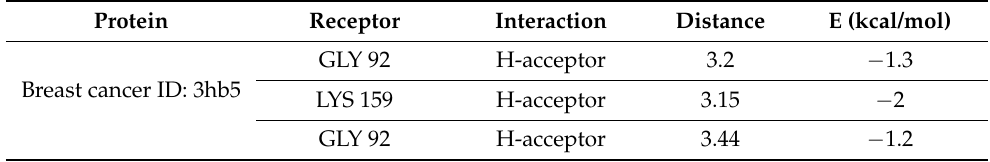
Table 8. Binding energy of the interaction with Au complex.